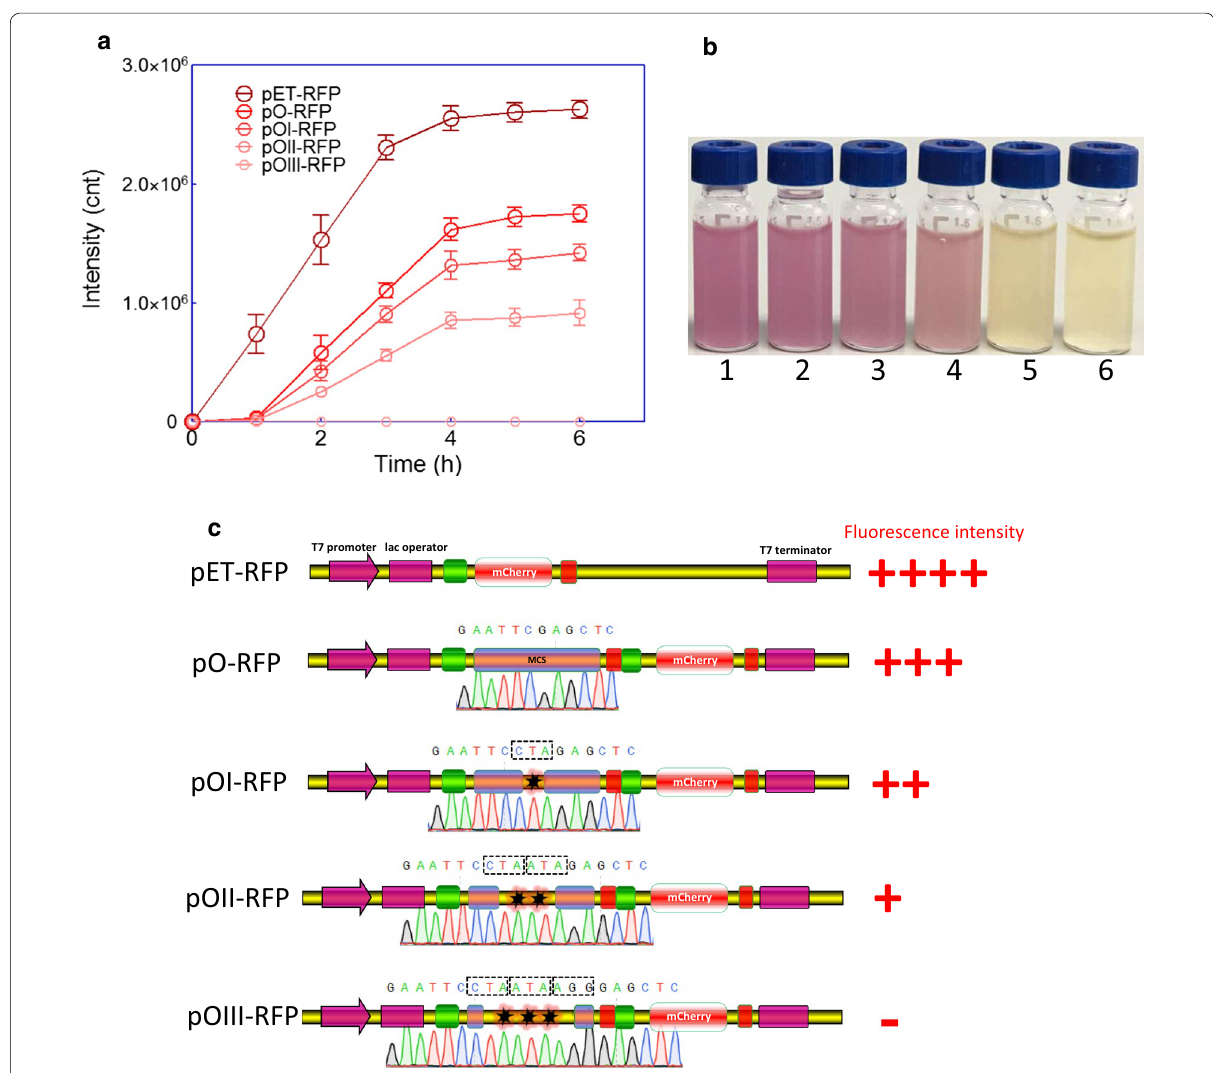
Fig. 2 Effect of rare codons in ORF1 on mCherry expression in ORF2 in E. coli strain BL21(DE3)pLysS. a BL21(DE3)pLysS harboring various plasmids were grown for 6 h in LB media after 0.5 mM IPTG induction. mCherry fluorescence of bacterial cells suspension was measured every hour using a Luminar fluorescence spectrometer. The fluorescence intensity is indicated as a fluorescence count value (unit are representative of three independent experiments and values are expressed as mean IPTG induction for 6 h. BL21(DE3)pLysS harboring different plasmids, 1. pET‑RFP; 2. pO‑RFP; 3. pOI‑RFP; 4. pOII‑RFP; 5. pOIII‑RFP; 6. Control, BL21(DE3) pLysS harboring pET‑21a with 0.5 mM IPTG induction. c Relationship of the genetic organization of recombinant plasmids and the expression level of the reporter gene